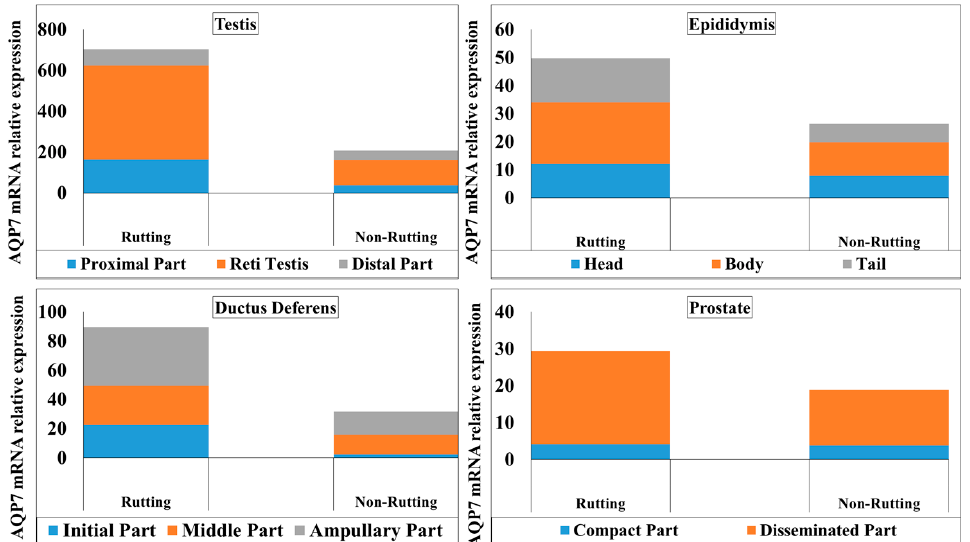
Figure 1. Relative normalized expression of mRNA levels of AQP-7 in testis, epididymis, ductus deferens and prostate.